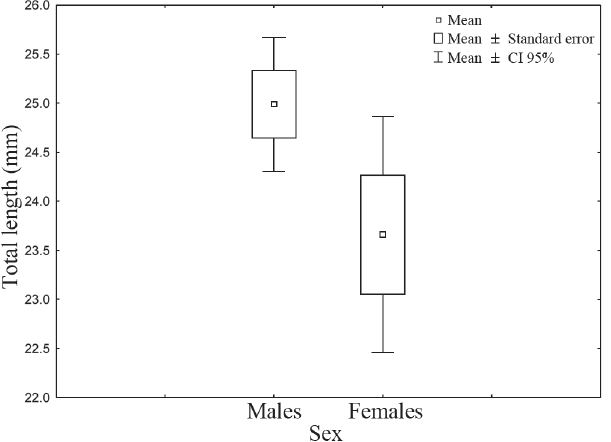
Fig. 2. Average, standard error and confidence interval (95%) for the lengths of males and females of Cynopoecilus melanotaenia from wetlands between São Gonçalo channel and